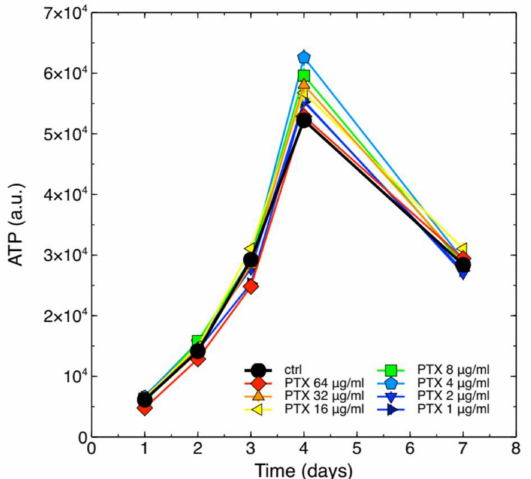
Figure 1. Growth kinetics of J774A.1 cells exposed to different concentrations of PTX. The drug was administered to the cells at the indicated final concentrations at the beginning of the growth assays, and ATP was then measured. Cell populations were also left untreated as controls (black circles marked as ctrl). The error bars correspond to calculated standard errors and are not clearly visible in this figure because they are masked by the symbols (min. and max. coefficient of variation, CV = 100 ∗ SE/mean, 0.75% and 6.0%, respectively).